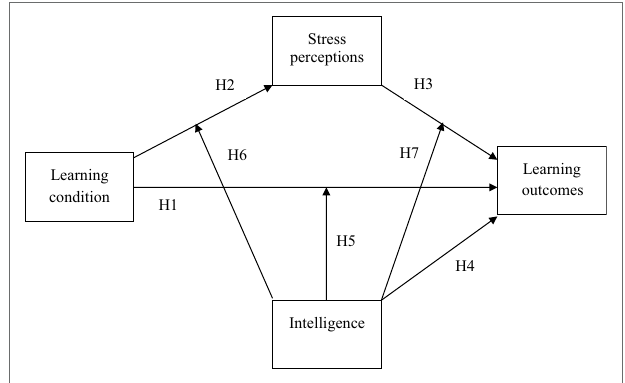
FIGURE 1 | Graphical depiction of the different variables and the assumed hypotheses. The learning condition consists of a re-reading control condition (0) and a test condition